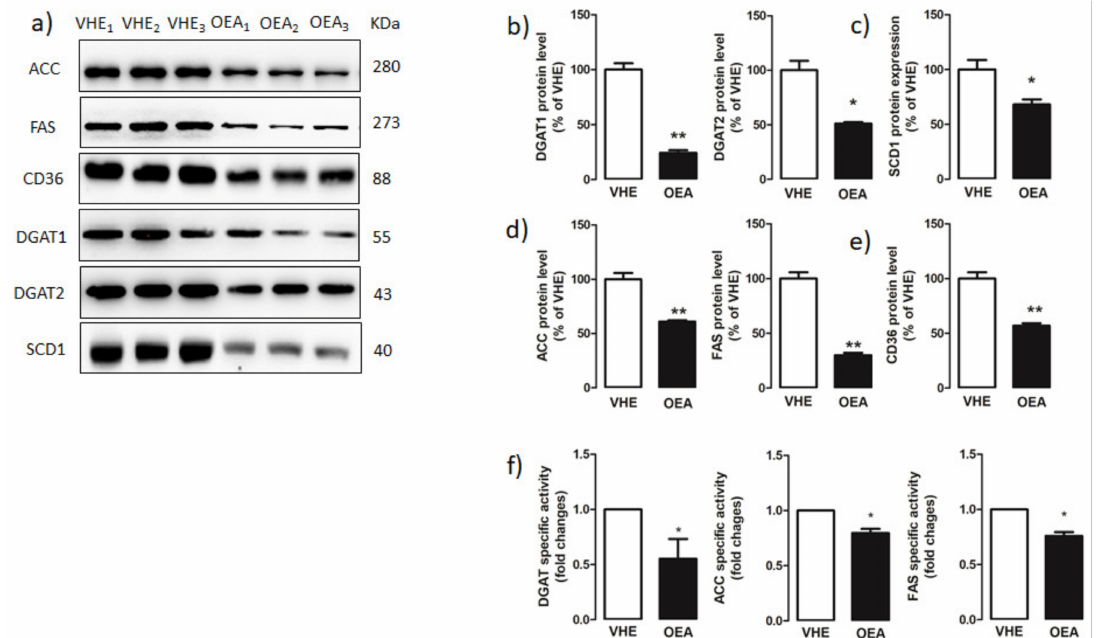
Figure 4. Hepatic fatty acid and triacylglycerol synthesis enzymes. ( a ) Proteins extracted from hepatic VEH and OEA samples were subjected to SDS-page electrophoresis. Membranes were analyzed by immunoblotting using specific antibodies for acetyl-CoA carboxylase (ACC), and fatty acid synthase (FAS), CD36, diacylglycerol acyltransferase 1 (DGAT1), DGAT2, and stearoyl-CoA desaturase 1 (SCD1). Each blot was normalized to the proper specific β -actin. ( b – e ) Blot signals were quantified by densitometric analysis and reported as % of the vehicle (VHE). ( f ) DGAT, ACC and FAS specific activities were assayed as reported in the Material and Methods section and reported as fold changes with respect to values measured in VEH rats. Values are the mean ± SEM of five different experiments. * p < 0.05; ** p <